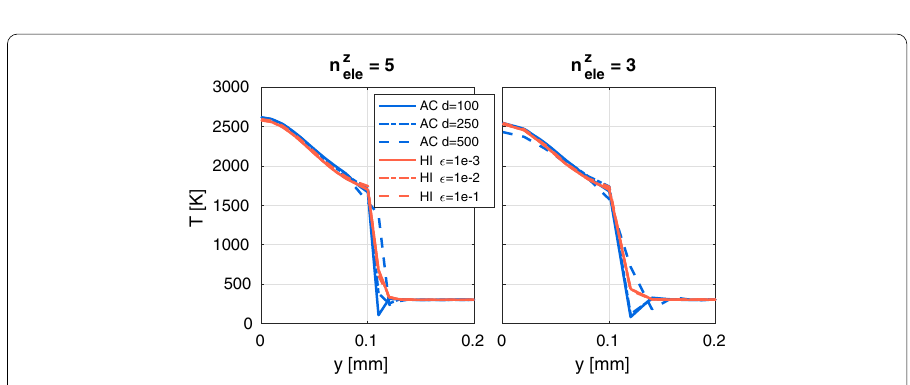
Fig. 23 Surface temperature profiles for AC with different phase change intervals transverse to laser path at x = 0 . 4mm showing transition from melt pool to powder